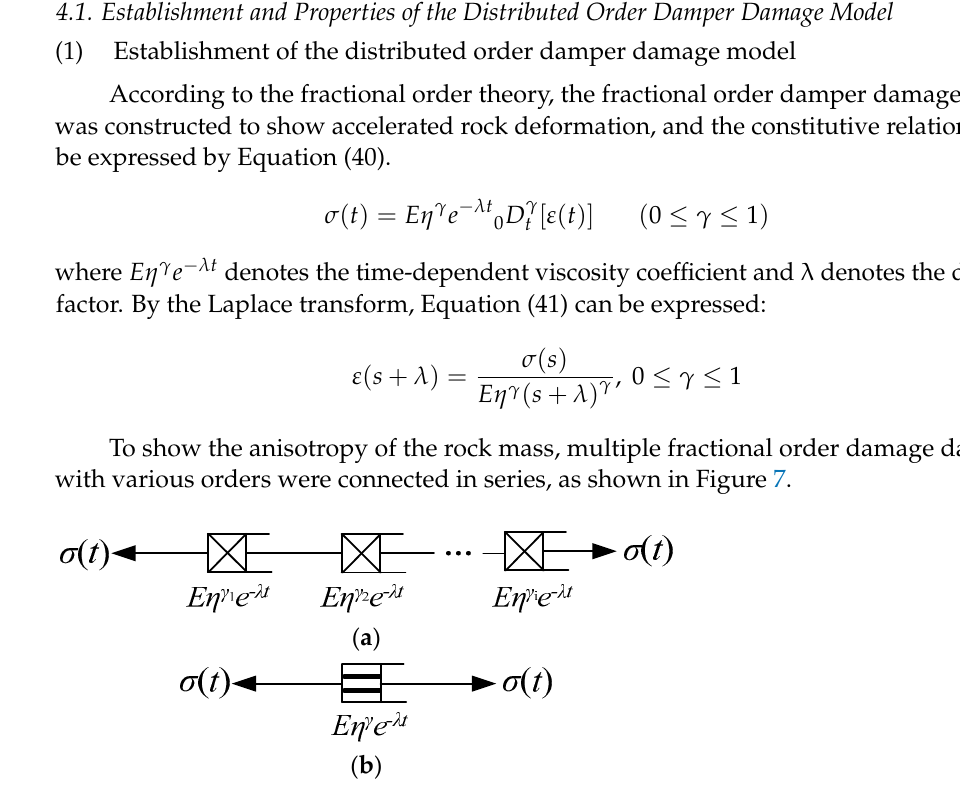
Figure 6. Response characteristics of the rheological properties of the distributed order rheological model.